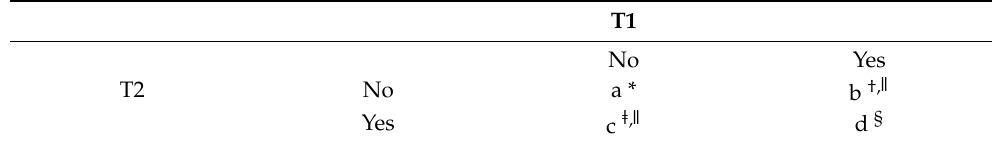
(Table 2: example of McNemar calculation). All analyses were conducted in Stata version 15 (StataCorp. 2017. College Station, LLC, Los Angeles, CA, United States). Table 2. Example of McNemar calculation.